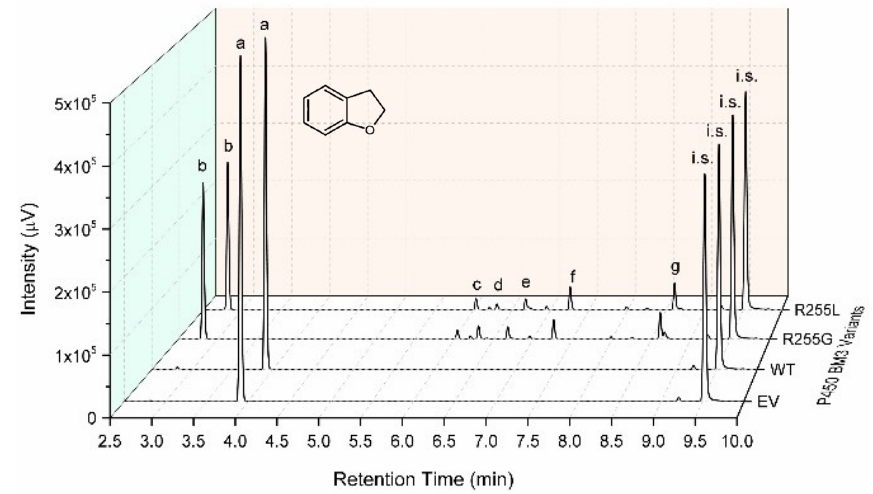
Figure A11. Product analysis via GC-FID after conversion of 2,3-dihydrobenzofuran with EV, P450 BM3 WT, and variants R255G and R255L. The data was obtained from 1 h conversion reactions employing GDH for efficient NADPH cofactor regeneration. a—2,3-dihydrobenzofuran, i.s.—cyclododecanol, b, c, d, e, f, g—unknown product. A total 2,3-dihydrobenzofuran depletion is visible with R255G and R255L, whereas the WT does not convert the substrate.